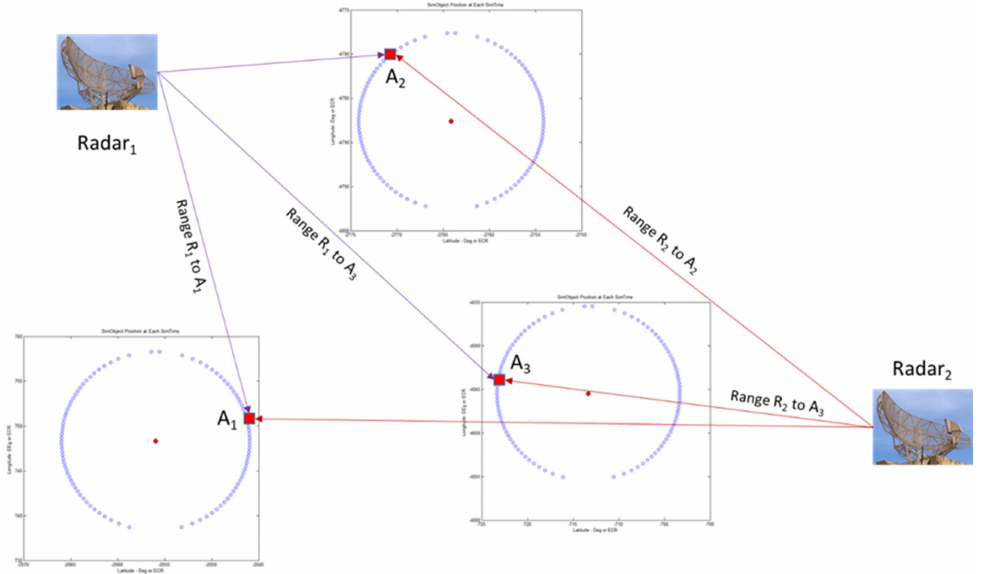
Figure 7. Simulation scenario (case study) using two classes of simulations objects (SOs) with their respective events and trajectories. These SOs are radars and